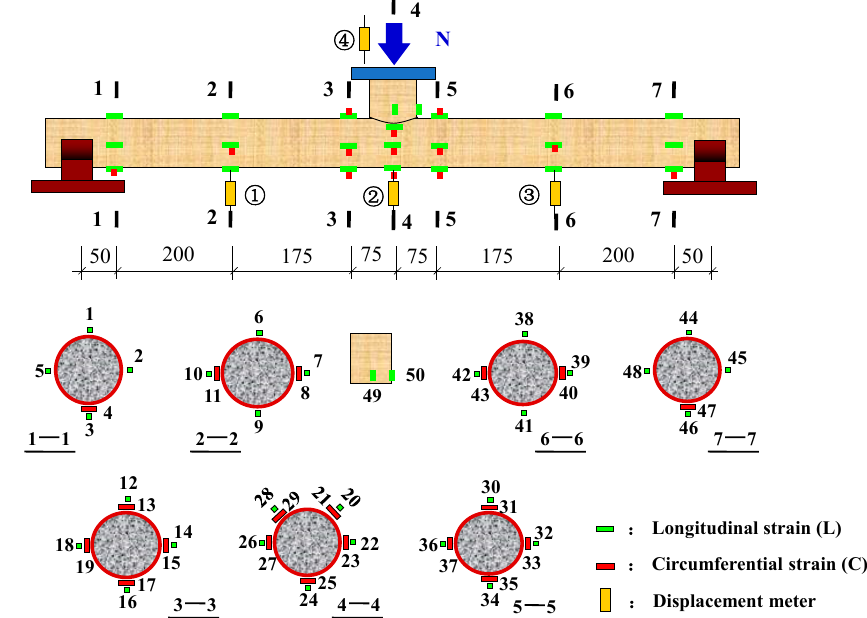
Figure 3. Layout of strain gauges and displacement meters.